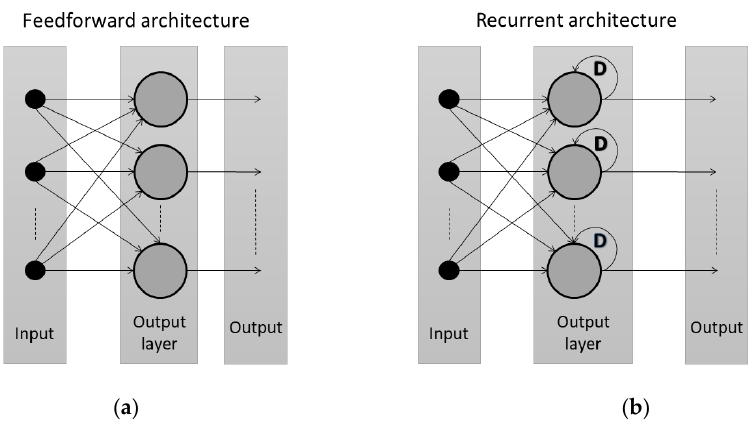
Figure 1. ( a ) Feedforward and ( b ) recurrent architecture layouts.